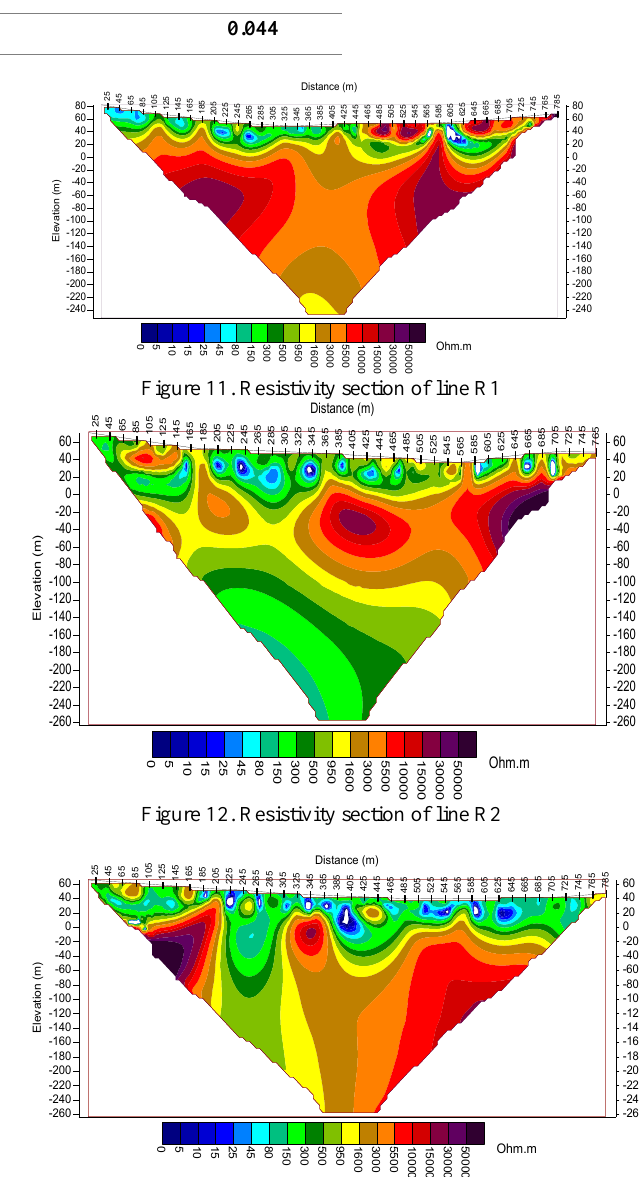
Figure 13. Resistivity section of line